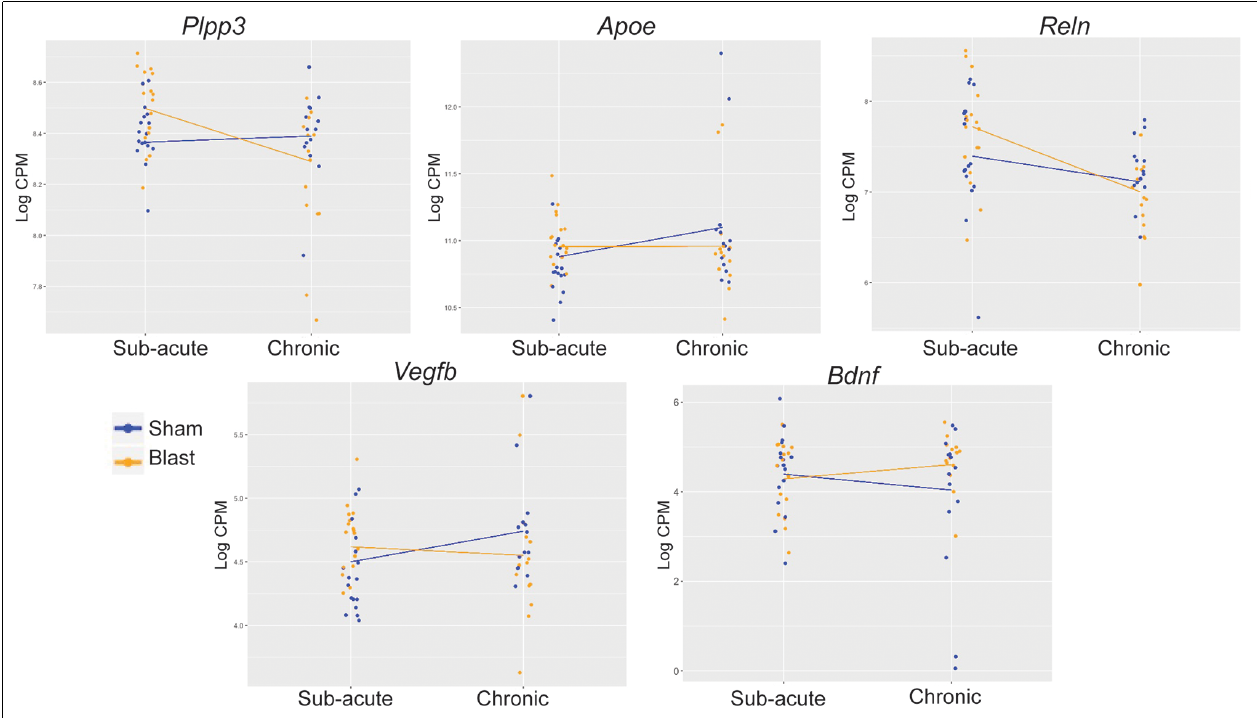
FIGURE 5 | Interaction plots for traumatic brain injury (TBI)- and neurodegeneration-associated candidate gene loci. Interaction analyses identified Plpp3 as displaying a significant interaction between blast exposure and timepoint after correction for multiple testing (adj. p -value < 0.05). Of the other significant interactions (unadjusted p < 0.05), we chose to depict interaction plots for TBI- and neurodegeneration-related genes Apoe, Vegfb, Reln , and Bdnf